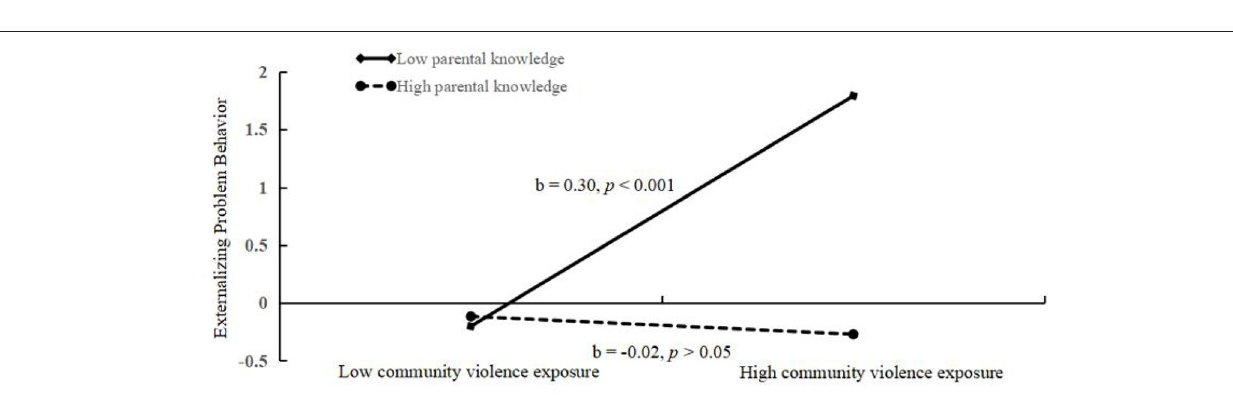
FIGURE 5 | Association between community violence exposure and externalizing problem behaviors at higher and lower levels of adolescent parental knowledge (After add covariate: school climate).